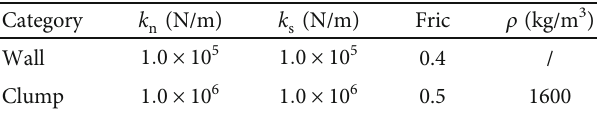
Figure 3: Gradation curve of numerical and indoor tests. Table 1: Preliminary mesoparameter assumption of tailing sand and